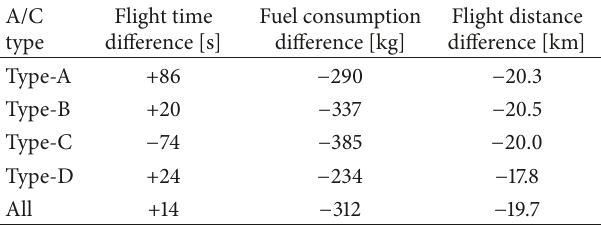
Table 4: Average of difference values for each aircraft